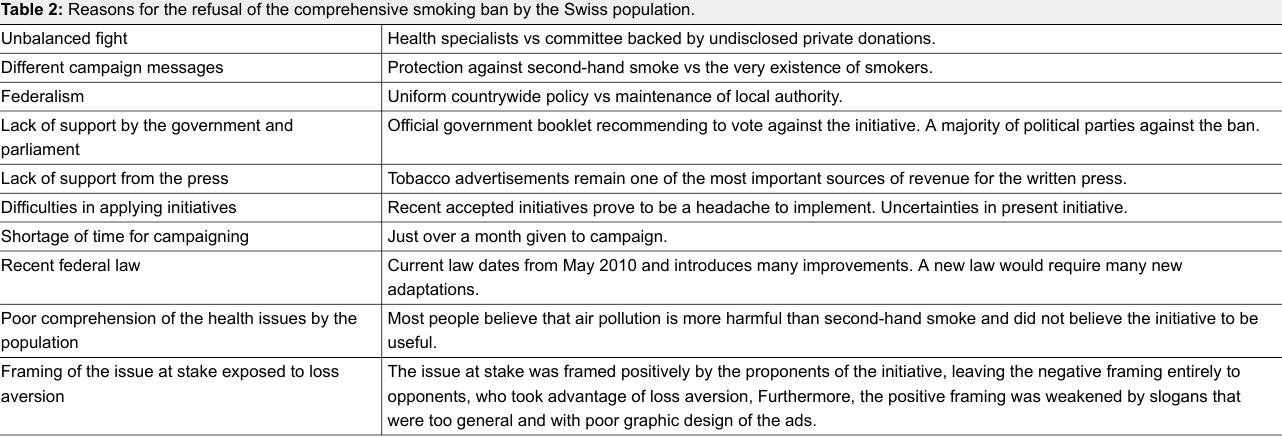
Table 2: Reasons for the refusal of the comprehensive smoking ban by the Swiss population. Unbalanced fight Health specialists vs committee backed by undisclosed private donations. Different campaign messages Protection against second-hand smoke vs the very existence of